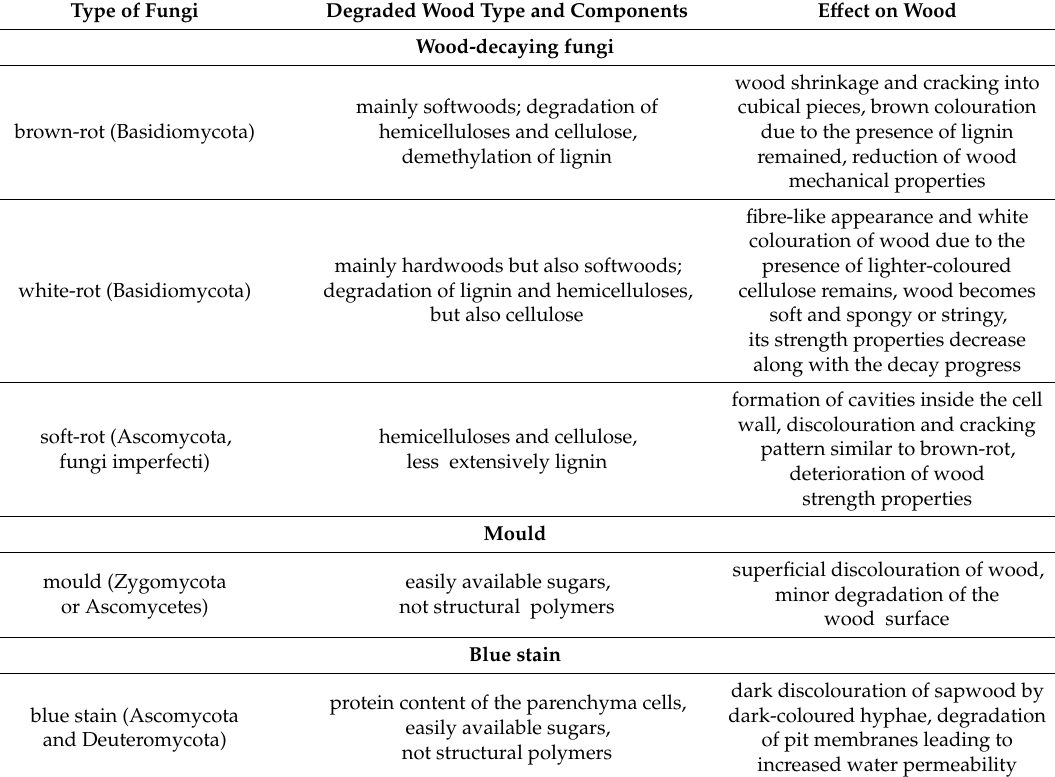
Table 1. The main types of fungi that can colonise and degrade wood